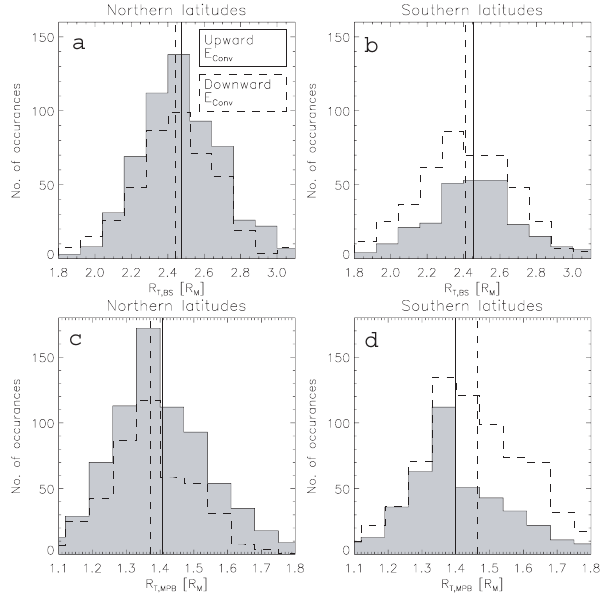
Fig. 7. Distribution of the extrapolated terminator distance of BS crossings in the (a) Northern and in the (b) Southern Hemisphere and MPB crossings in the (c) Northern and in the (d) Southern Hemisphere observed by MEX from February 2004 until November 2006. In each panel, the distributions are subdivided into whether they occur when the convective electric field is directed locally up- ward (solid, filled) or locally downward (dashed). The mean extrap- olated terminator distances are shown for crossings that occur in the locally upward convective electric field hemisphere (solid vertical line) and in the locally downward convective electric field hemi- sphere (dashed vertical